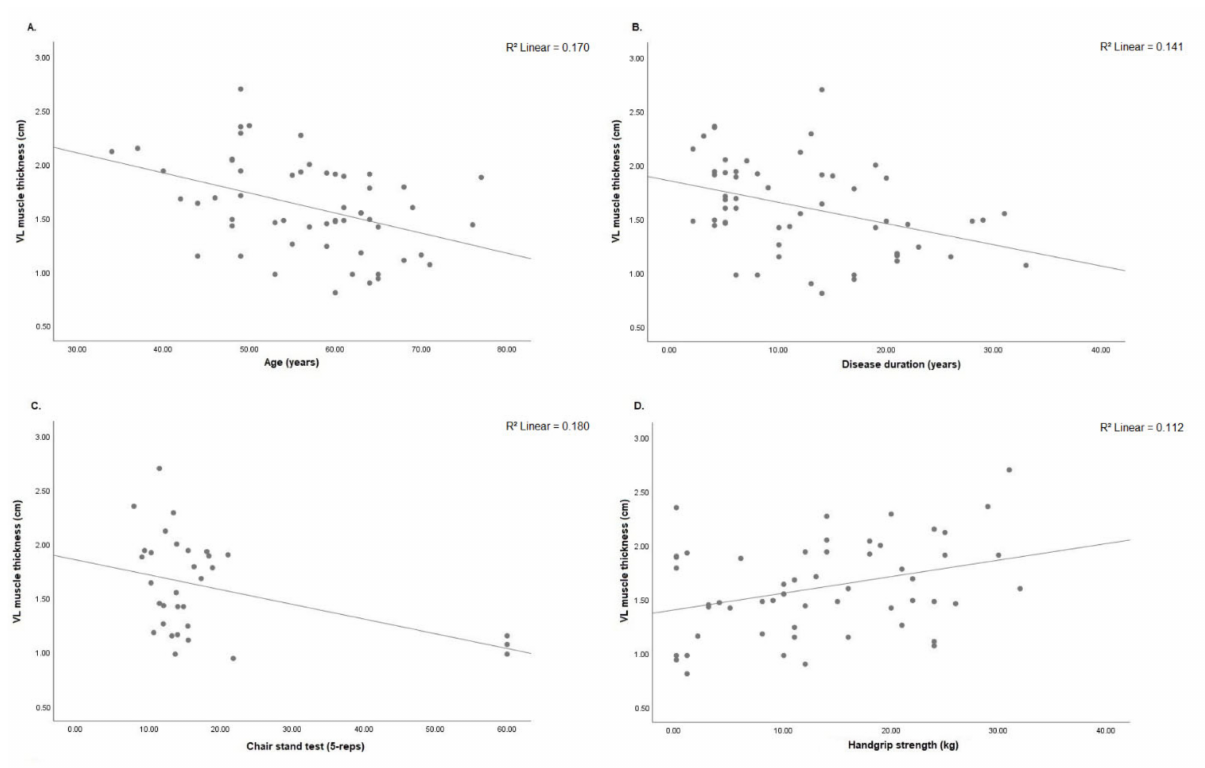
Figure 6. ( A ) Correlation analysis was significant between VL muscle thickness and age ( n = 55, r = − 0.412; p = 0.002), ( B ) disease duration ( n = 55, r = − 0.426; p = 0.001), ( C ) chair stand test ( n = 32, r = − 0.394; p = 0.026) and ( D ) handgrip strength ( n = 55, r = 0.335; p = 0.013). VL: vastus lateralis; cm: centimeters; 5-reps: five repetitions; kg: kilograms.